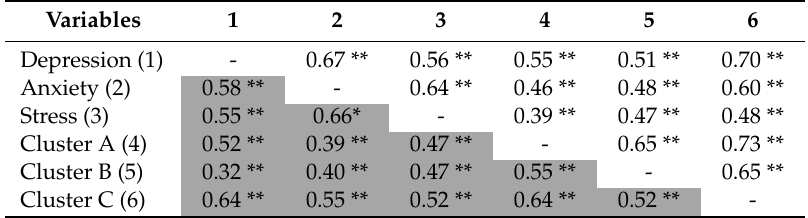
Table 4. Bivariate Pearson correlations between variables among users of an account on Facebook and on Twitter (n = 389) regarding